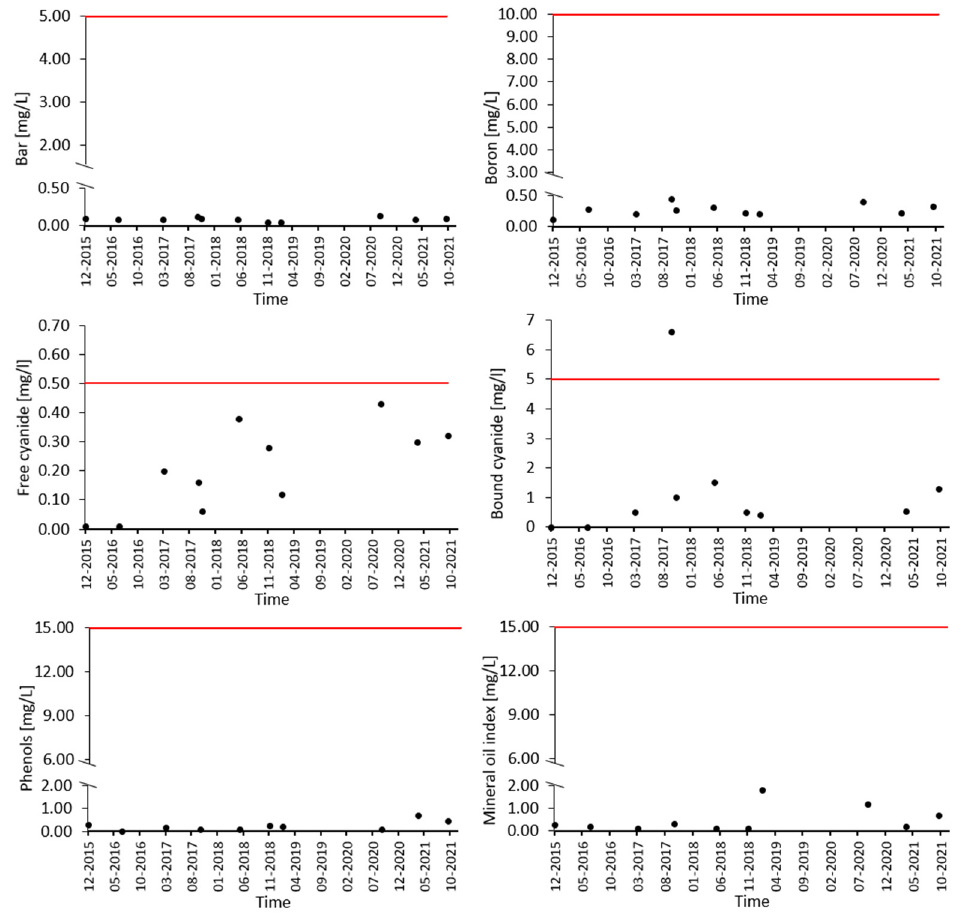
Figure 6. The contents of other chemical parameters in the industrial wastewater generated on the ZUOK site in Olsztyn between December 2015 and December 2021. The red line indicates the permissible values as set out in the integrated permit.